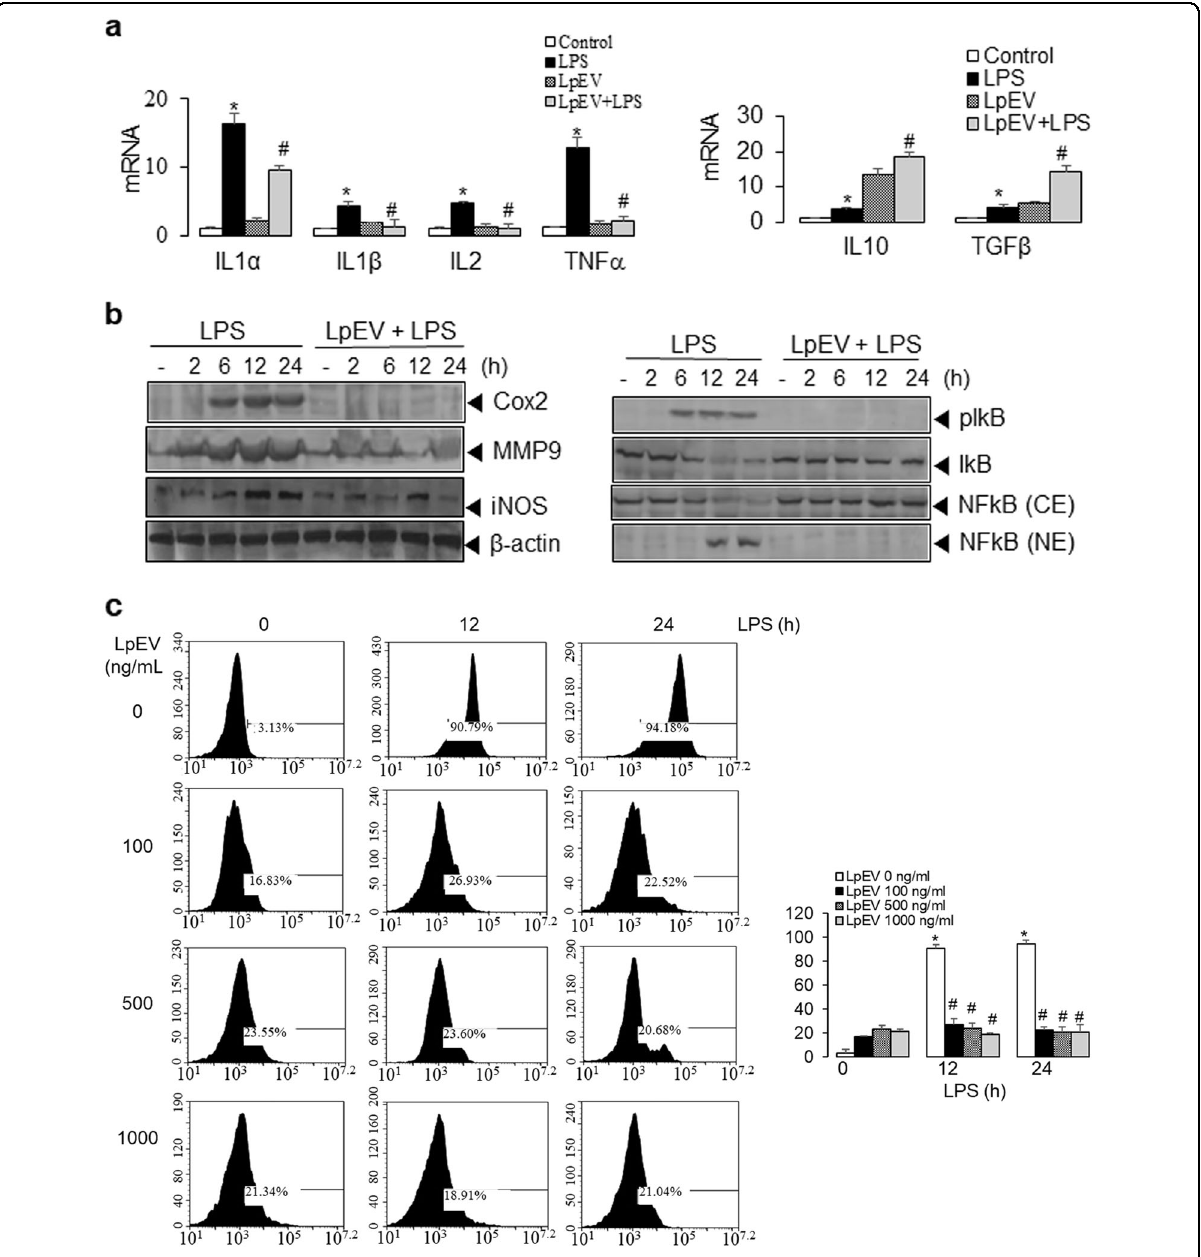
Fig. 3 Effects of LpEVs on LPS-induced in fl ammatory responses in human colorectal cancer cells. a HT29 colorectal cancer cells were pretreated with vehicle or 500 ng/mL LpEVs for 12 h and treated with vehicle (control) or 1 mg/mL LPS for 12 h. The mRNA expression of in fl ammatory cytokines was then analyzed by qRT-PCR, and the percent mRNA expression was plotted as the mean±standard deviation of at least three experiments. b HT29 cells were pretreated with vehicle or 500 ng/mL LpEVs for 12 h and then treated with 1 mg/mL LPS for 0, 2, 6, 12, and 24 h. The cells were lysed, and the cell lysates were subjected to SDS-PAGE and western blot analysis using antibodies against COX-2, MMP-9, iNOS, phospho-I κ B and I κ B, and β -actin. To detect the nuclear translocation of NF κ B, cell lysates were fractionated into the nuclear extract (NE) and cytosolic extract (CE) and then analyzed by western blot analysis using an antibody against NF κ B p65. c The cells were stained with 2,3- diaminonaphthalene for 15 min. NO production was measured by fl ow cytometry ( N = 3 for each experimental group). The percentage of NO production was calculated based on naphthalene triazole fl uorescence and plotted as the mean±standard deviation of at least three experiments. * P < 0.01 compared with vehicle-treated control cells. # P < 0.01 compared with LPS-treated cells without LpEVs.